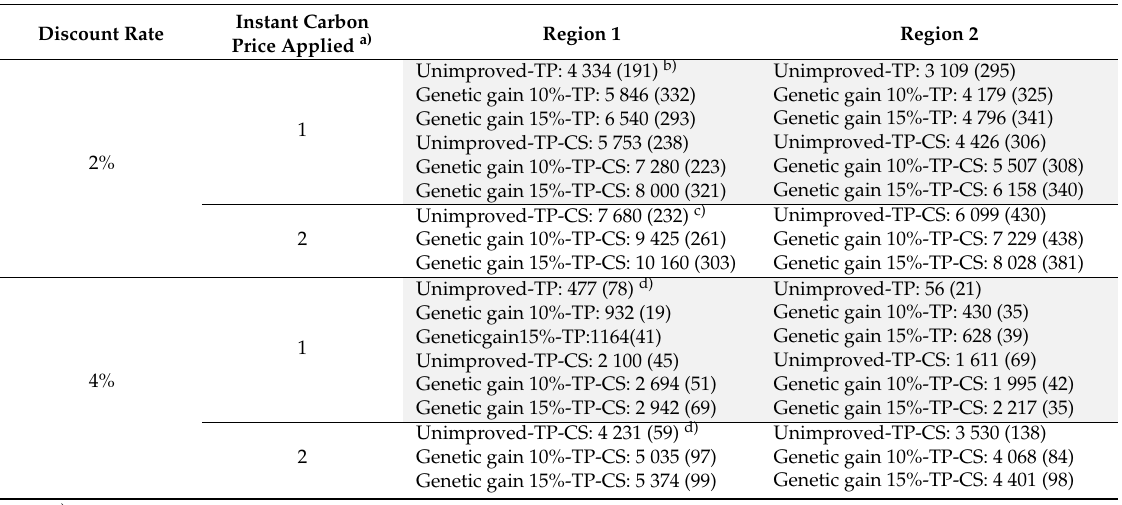
Table 2. E ff ect of discount rate and carbon pricing on the MaxLEVs, € / ha. Shading refers to carbon price 1 with 2% and 4% discount